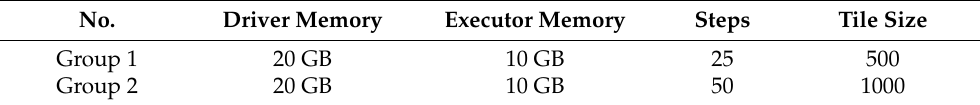
Table 4. The immutable parameter settings of the Spark Submit System in the experiment. No. Driver